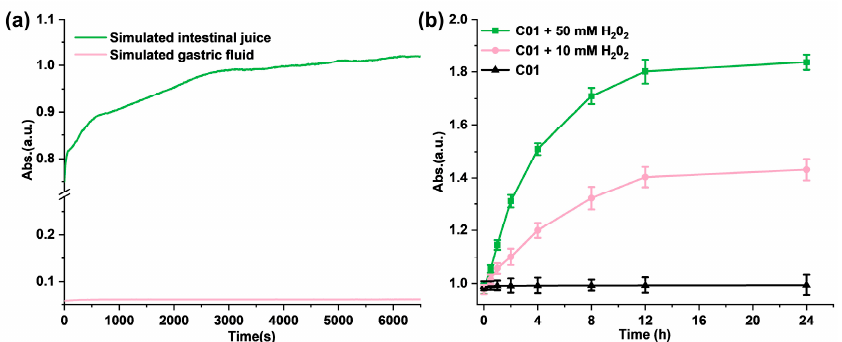
Figure 2. ( a ) The hydrolysis kinetics of M1 in solution in simulated gastric juice and simulated intestinal fluid; ( b ) ROS-responsive fragmentation of M1 molecules in PBS in vitro.